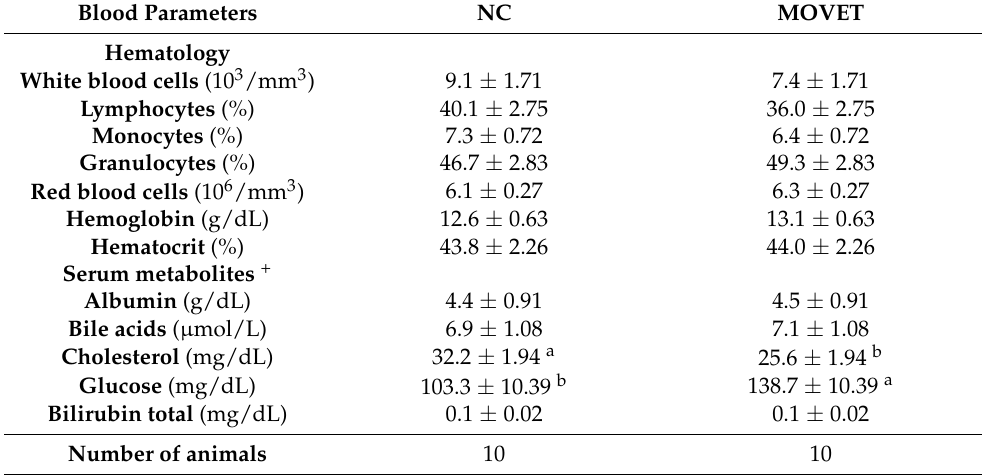
Table 1. Comparison of hematological and biochemical profile changes of F3 generation animals derived from early embryos exposed to the combination of multiple ovulations, vitrification and embryo transfer (MOVET) and naturally conceived